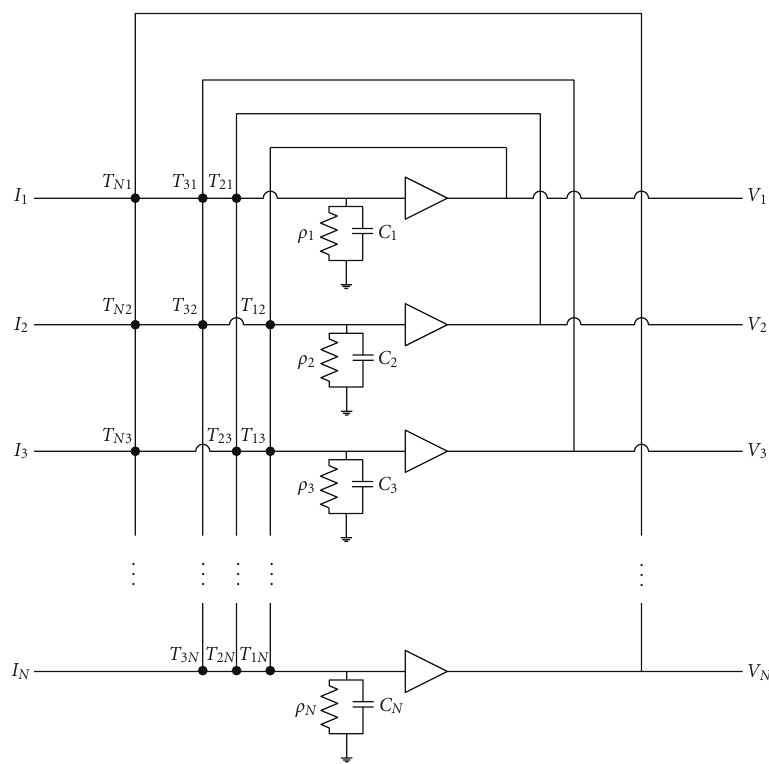
Figure 1: Hopfield network circuit